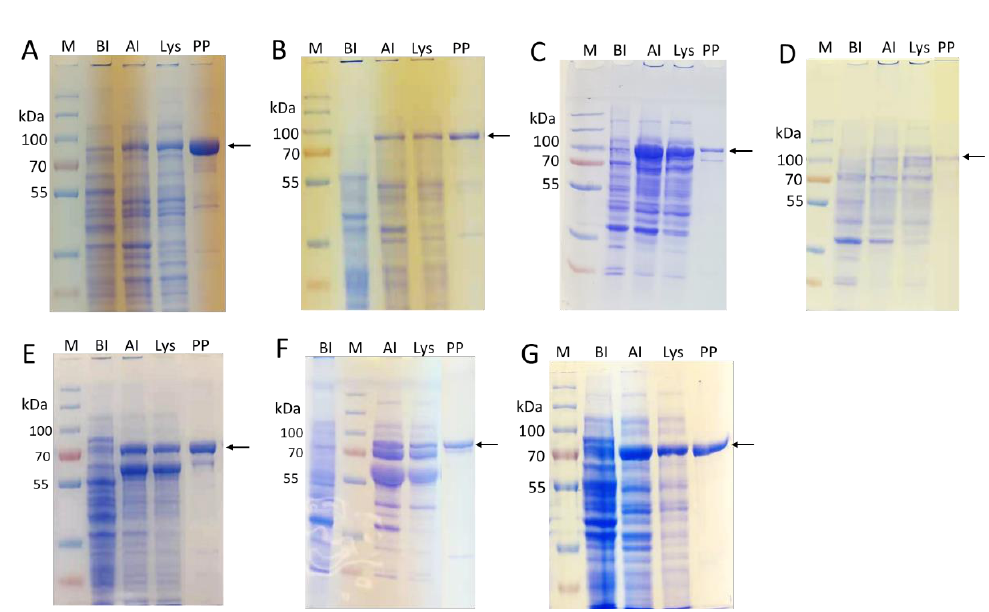
Figure 2. SDS-PAGE analysis results for enzyme expression and purification. ( A ) ∆ 24Bt3994-His 6